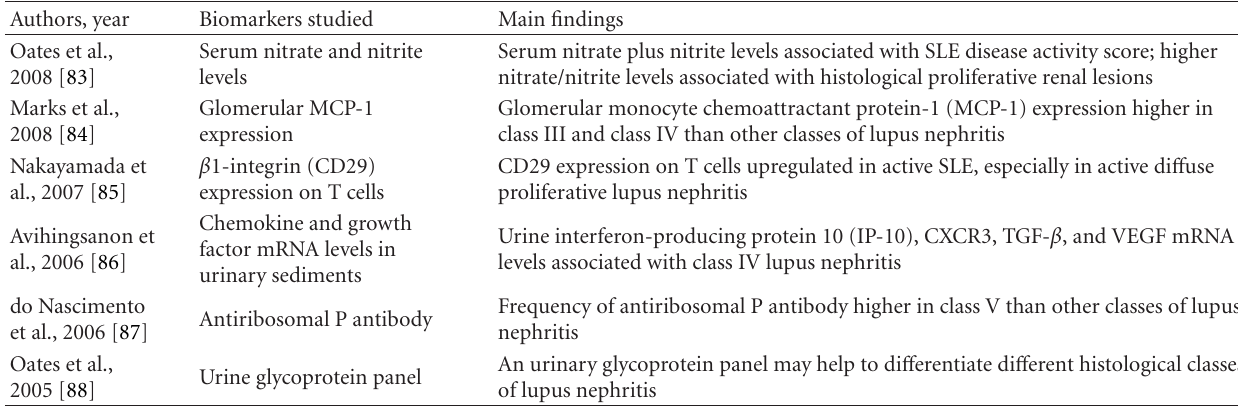
Table 3: Biomarkers that correlate with histological findings in lupus nephritis.